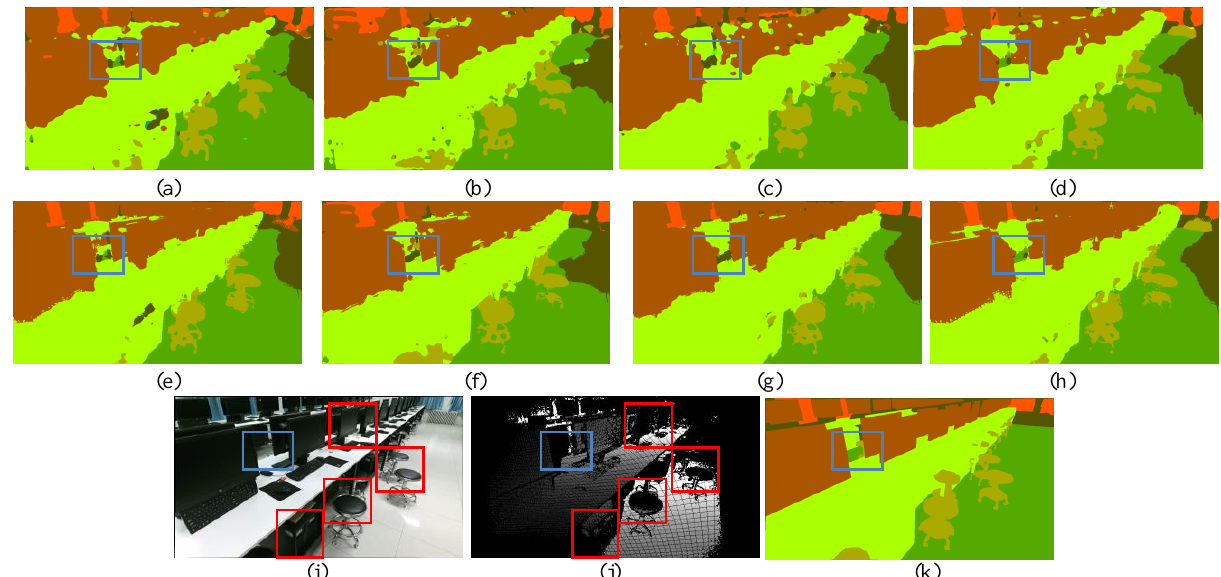
Figure 3. Another example of Semantic segmentation results of eight methods. (a) RGB, (b) RGBD, (c) RGBD+MMD1, (d) RGBD+MMD2, (e) RGB+CRF, (f) RGBD+CRF, (g) RGBD+MMD1+CRF, (h) RGBD+MMD2+CRF, (i) RGB image, (j) Depth image, (k) Ground truth